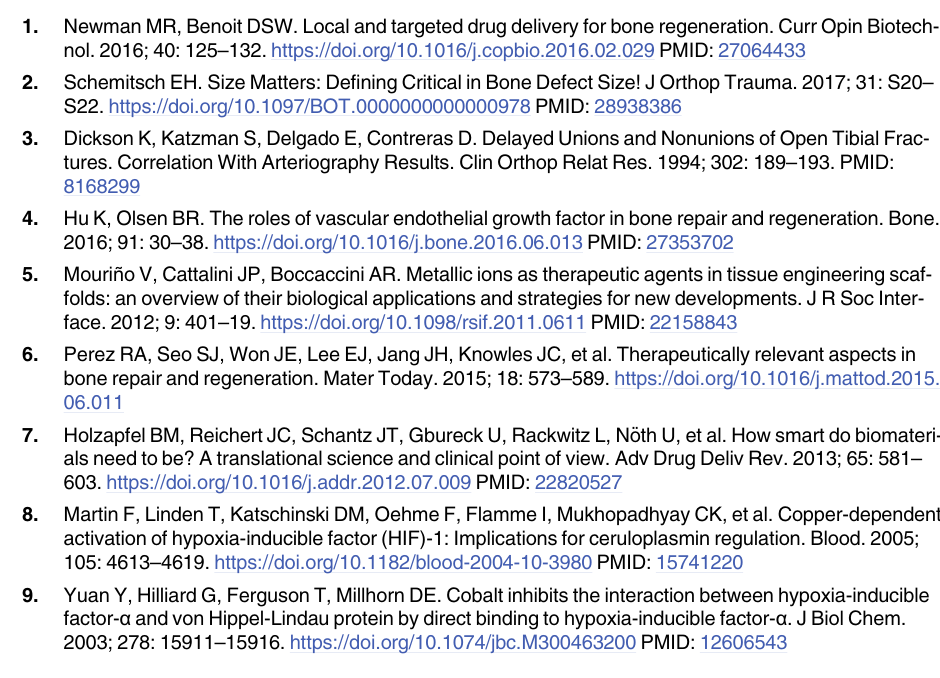
S1 Table. HIF-1 α and VEGF expression correlation results with Cu 2+ supplementation.